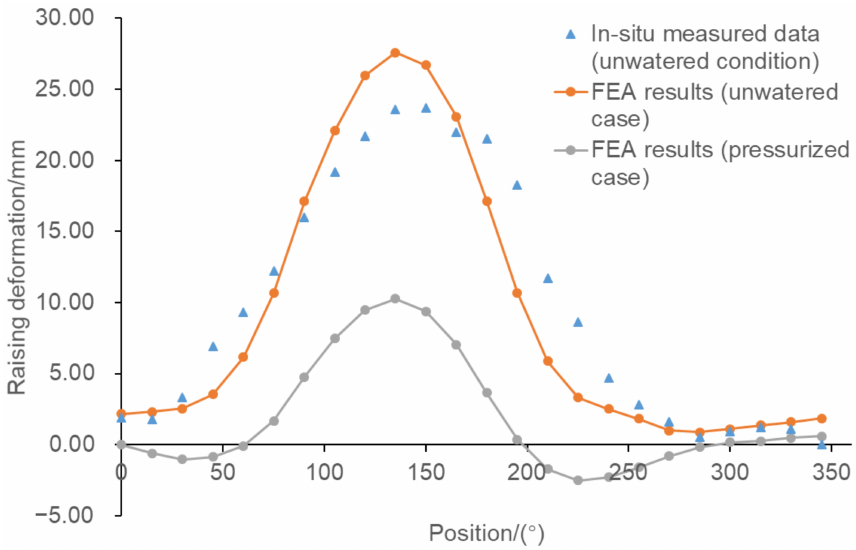
Figure 11. Raising deformation of the upper stay